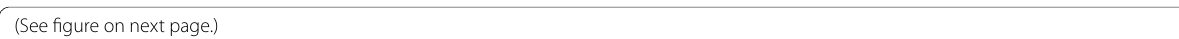
numbered(See figure on next Fig. 3 Histogram of influenza mutations by HA amino acid residue. Bars show the number of mutations at each amino acid observed in variants isolated, by sets of five residues as